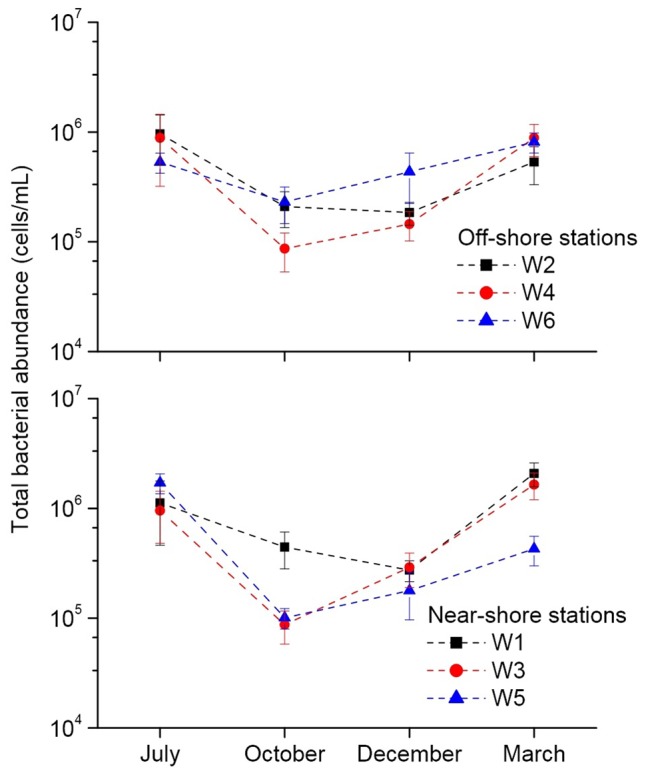
Fluorescence microscopy based quantification of total bacteria at the near-shore and off-shore stations near the Qinhuangdao coastal area of Bohai Sea. ‘W1’ to ‘W6’ indicate the different sampling stations.